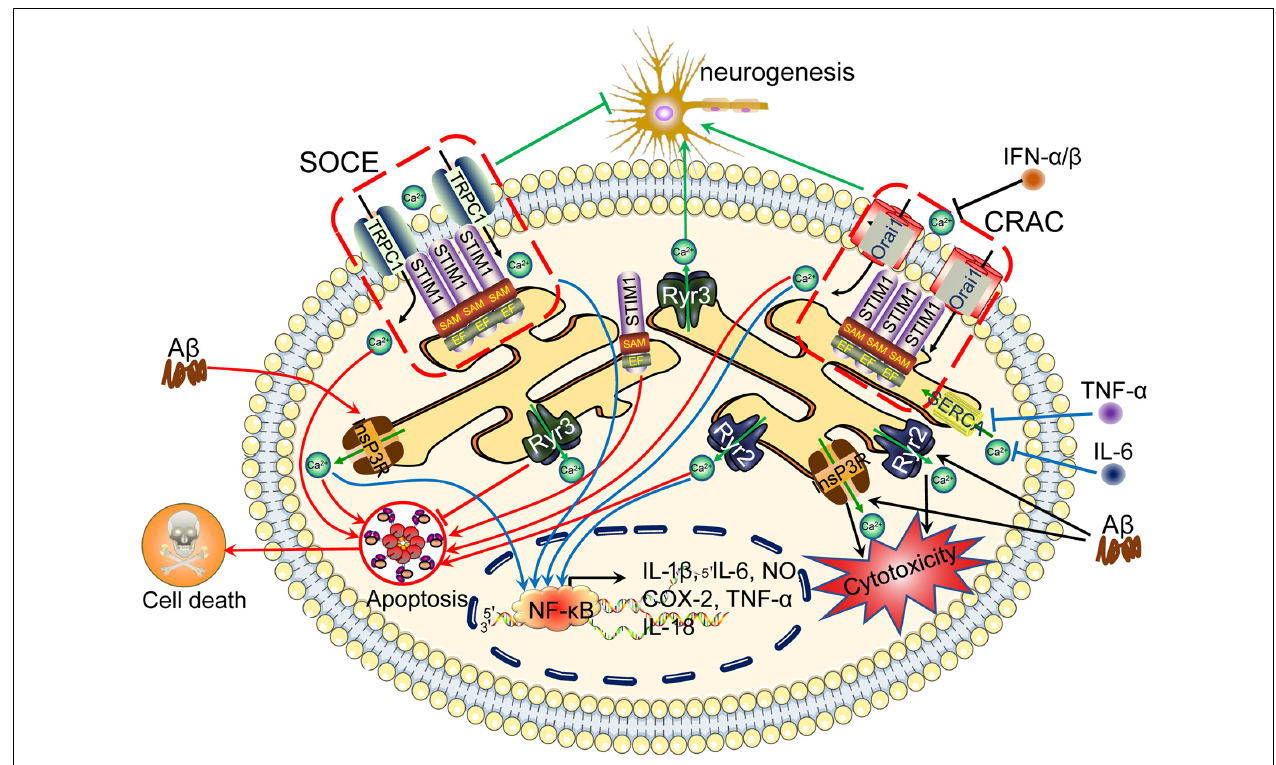
FIGURE 2 | Ca 2+ channels in the ER are involved in regulating neuroinflammation, apoptosis, tau phosphorylation and A β deposition, leading to cognitive impairment. The accumulation of A β in neuronal cells induces Ca 2+ influx from the intracellular Ca 2+ store, namely, the ER. In addition, Ca 2+ depletion from the ER triggers sustained extracellular Ca 2+ influx to the cytosol via a SOCE pathway, including TRPC1 and Orai1, by activating the Stim. During these processes, InsP3R and RyR2 play important roles in inducing Ca 2+ influx from the ER to the cytosol, regulating apoptosis, neurogenesis, tau phosphorylation and A β deposition and subsequently leading to cognitive impairment. ER, endoplasmic reticulum; SOCE, store-operated calcium